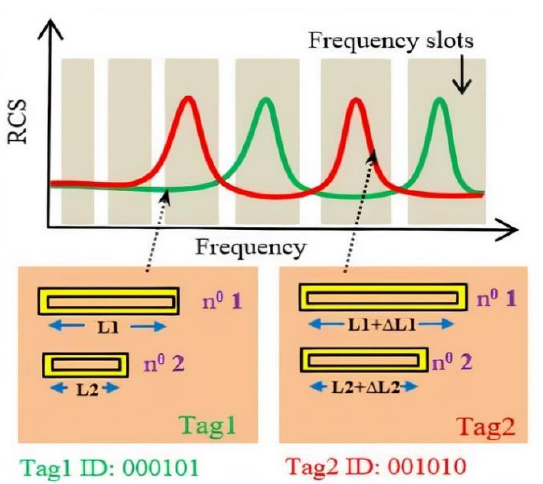
Figure 2. Frequency Position Coding (FPC) technique used in chipless RFID.